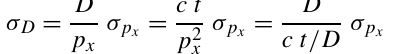
Figure 10. Camera setup at the Research Center Jülich (map source: OpenStreetMap